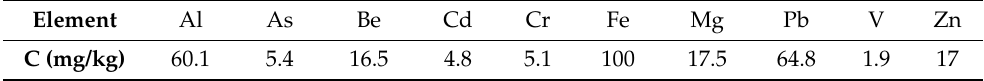
Figure 4. SEM analysis of phosphate waste before treatment at different magnifications. Table 2. Concentrations of elements present in the waste before treatment obtained by ICP. Element